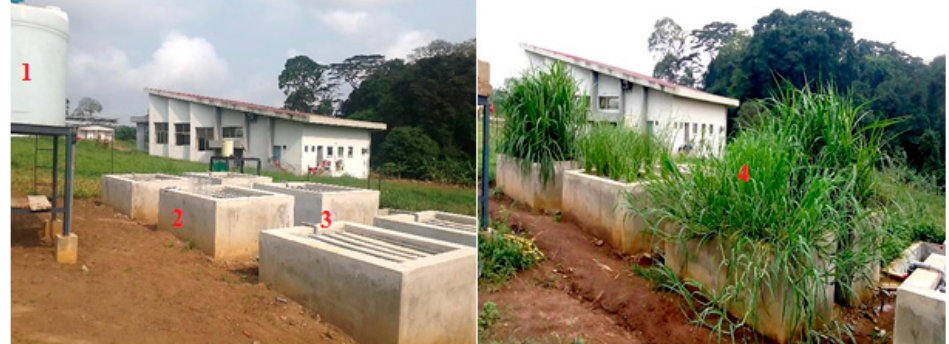
Figure 1. The experimental setup of the study; (1) feeding tank, (2) pilot VFCW beds, (3) inlet feeding pipes, (4) plant growth in the pilot beds two months after planting. pipes, (4) plant growth in the pilot beds two months after